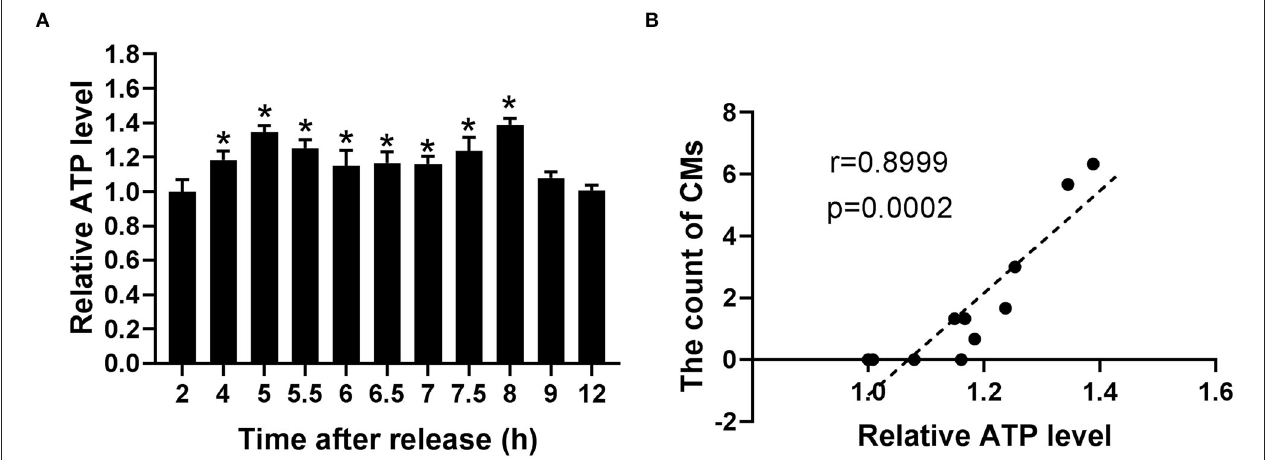
FIGURE 6 | The occurrence of CMs in G2 phase was correlated with ATP level. (A) Histograms represented the change of ATP level at indicated time points after release. All of the values were denoted as the means ± SD; N = 3. * P ≤ 0.05, compared to the 2h group. (B) Pearson’s correlation analysis showed the correlation between the average count of CMs and relative ATP